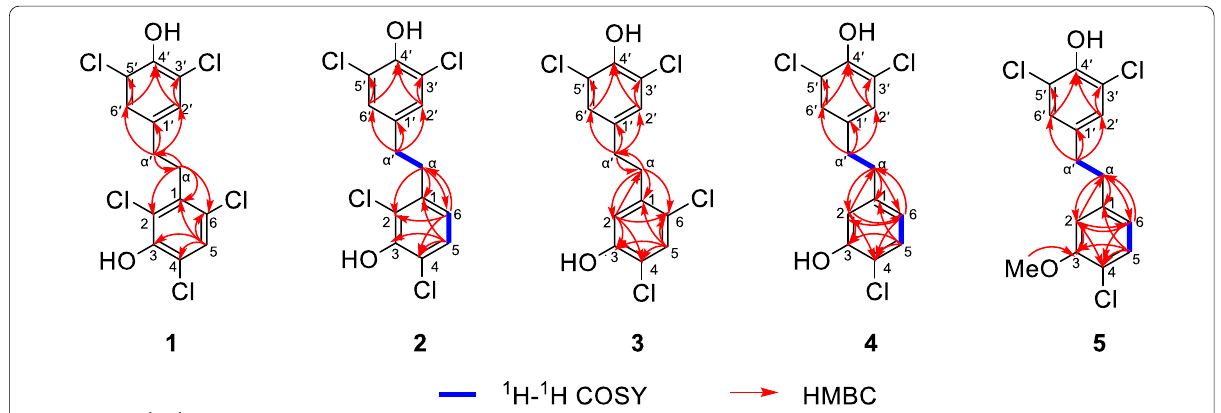
Fig. 2 The key 1 H– 1 H COSY and HMBC correlations for compounds 1 – 5